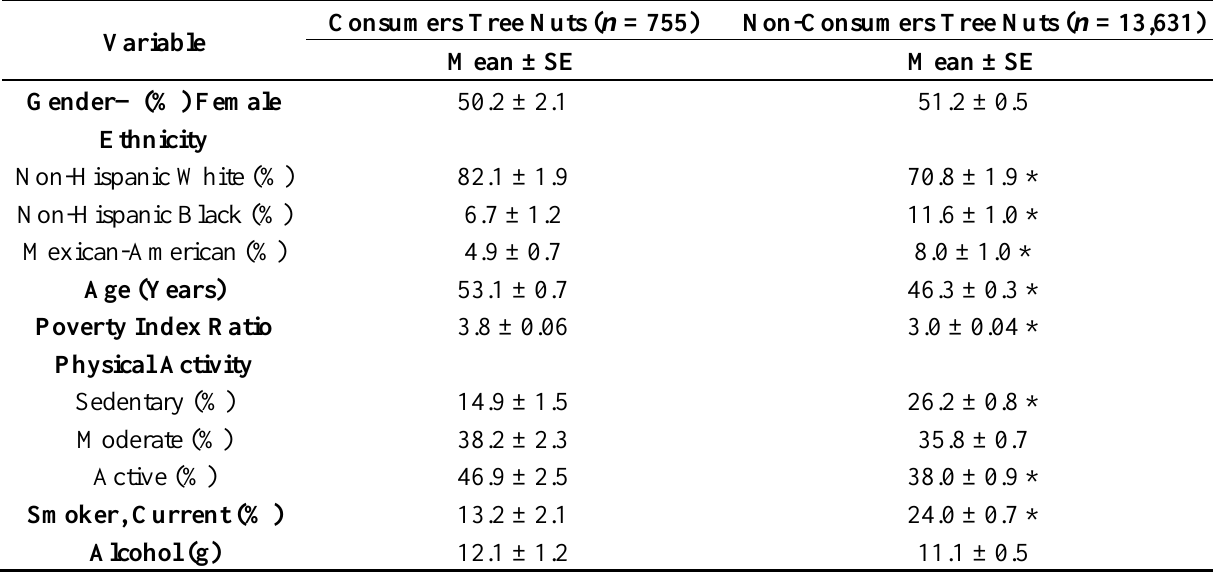
Table 1. Descriptive statistics of adult tree nut consumers participating in the National Health and Nutrition Examination Survey